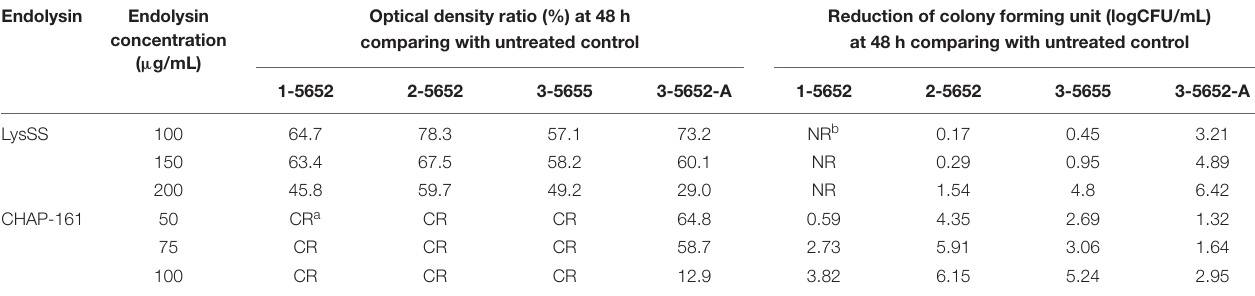
FIGURE 4 | Counting viable bacterial cells after adding endolysin CHAP-161 to the catheter solution. (A) 1-5652, (B) 2-5652, (C) 3-5655, (D) 3-5652-A. These results were statistically evaluated and expressed with standard deviation error bars from three independent experiments. TABLE 3 | Antibacterial effects of LysSS and CHAP-161 on catheter-contaminating bacteria from four catheters (1-5652, 2-5652, 3-5655, and 3-5652-A). Endolysin Optical density ratio (%) at 48